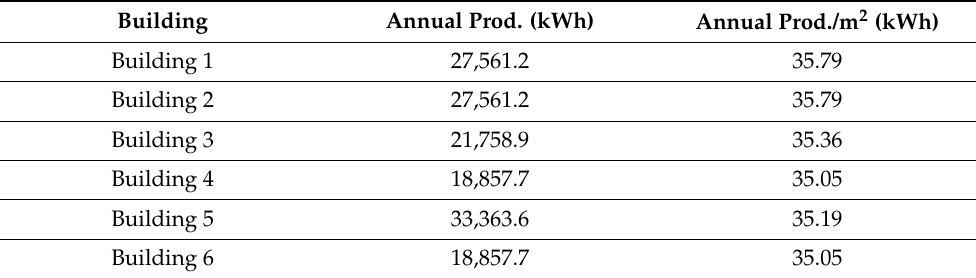
Table 6. PV yearly energy